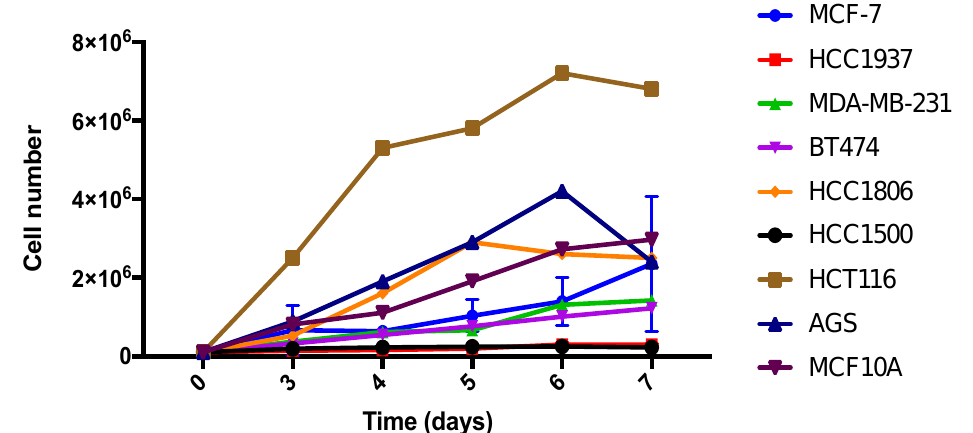
Figure 4. Cell growth over 7 days in cell lines treated with Runat-BI. Cell growth was measured with the Neubauer chamber using “Automated Cell Counter TC10 TM ”. Dots indicate the mean of two independent experiments.